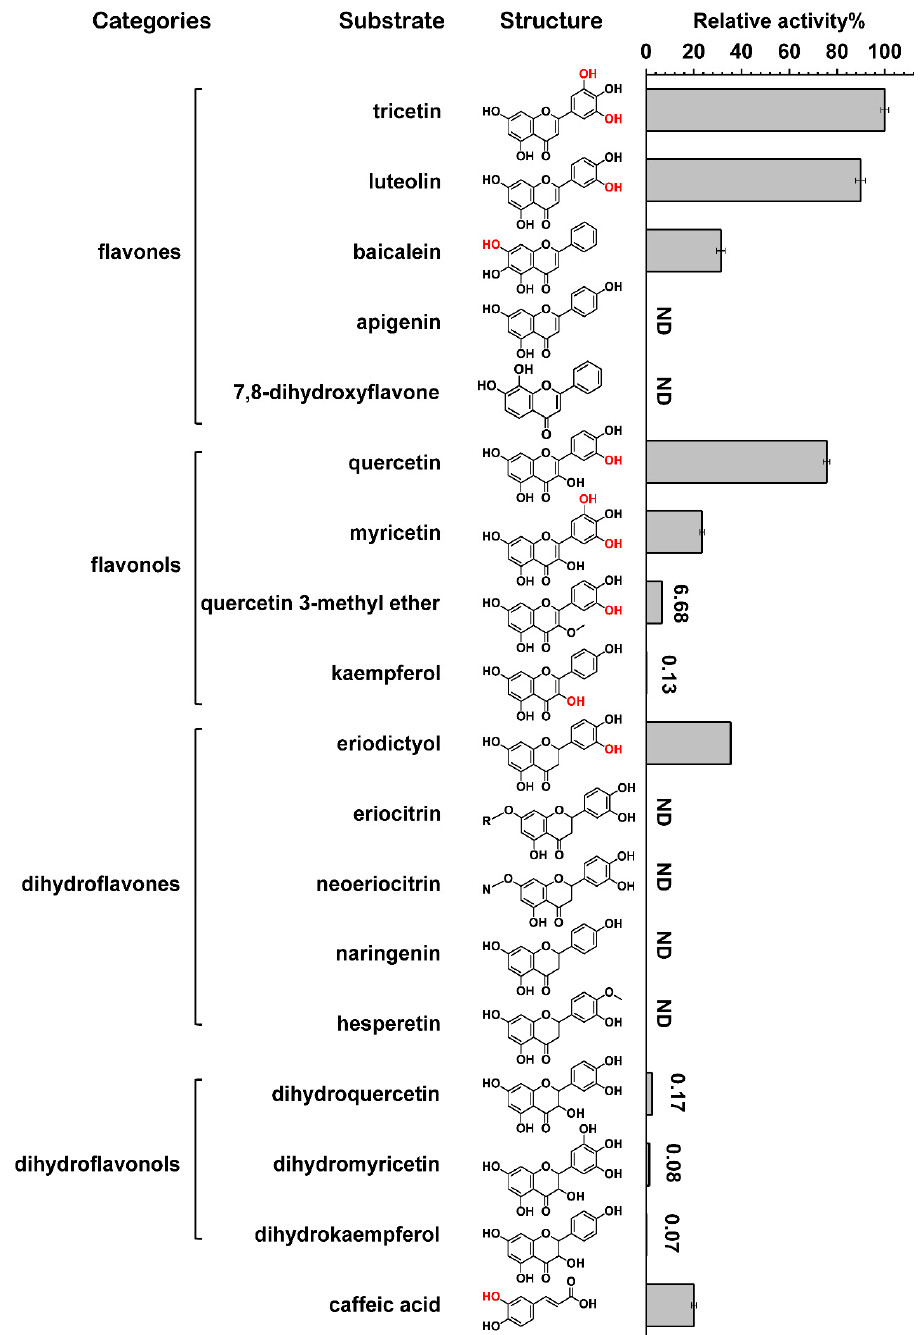
Figure 1. Relative activity of Citrus reticulata O -methyltransferase 2 (CrOMT2) against four representative flavonoids and caffeic acid in vitro. The recombinant CrOMT2 purified from Escherichia coli was incubated with a number of phenolic substrates, and the relative activity against different substrates was estimated. The methylation sites identified for substrates are indicated in red in their structural formula. ND represents “not detectable”. R- in eriocitrin represents rutinoside and N - in neoeriocitrin represents neohesperidoside. The data are shown as means ± SE (n = 3).